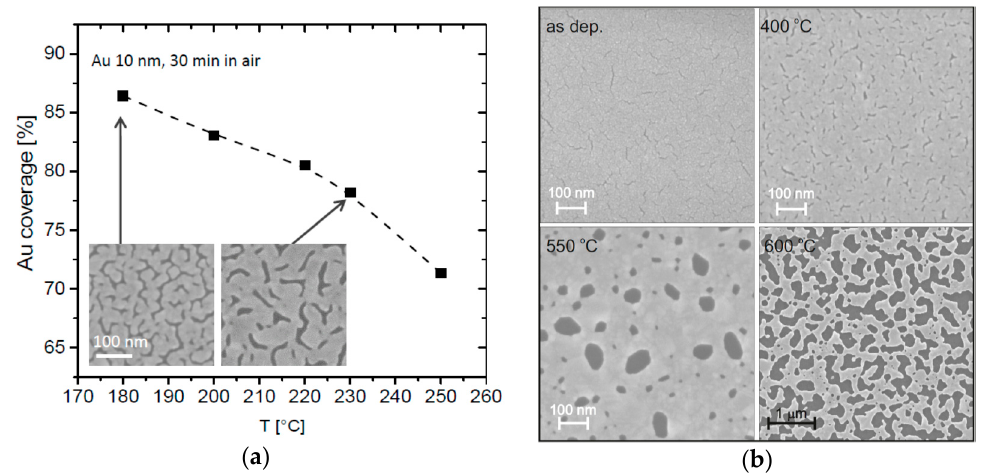
Figure 4. ( a ) Au coverage in percentage of the surface area measured in SEM images in plan-view as a function of the annealing temperature. The Au film thickness was 10 nm and the annealing was performed in air for 30 min. Insets show SEM images of Au film annealed at 180 ◦ C (left) and 230 ◦ C (right), the scale marker is the same in both images. The figure was adapted with permission from L. Romano et al., 2017. [40] ( b ) Pt de-wetting (12 nm) on (100) Si substrate at temperature of 400, 550, and 600 ◦ C. The figure was adapted with permission from L. Romano et al., 2020. [21].